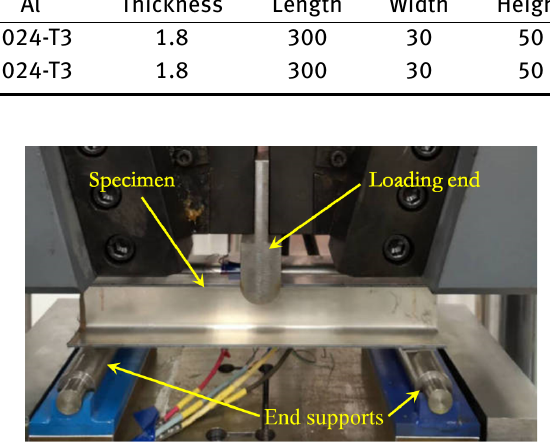
Figure 4: Three-point bending test setup for double-channel CARALL